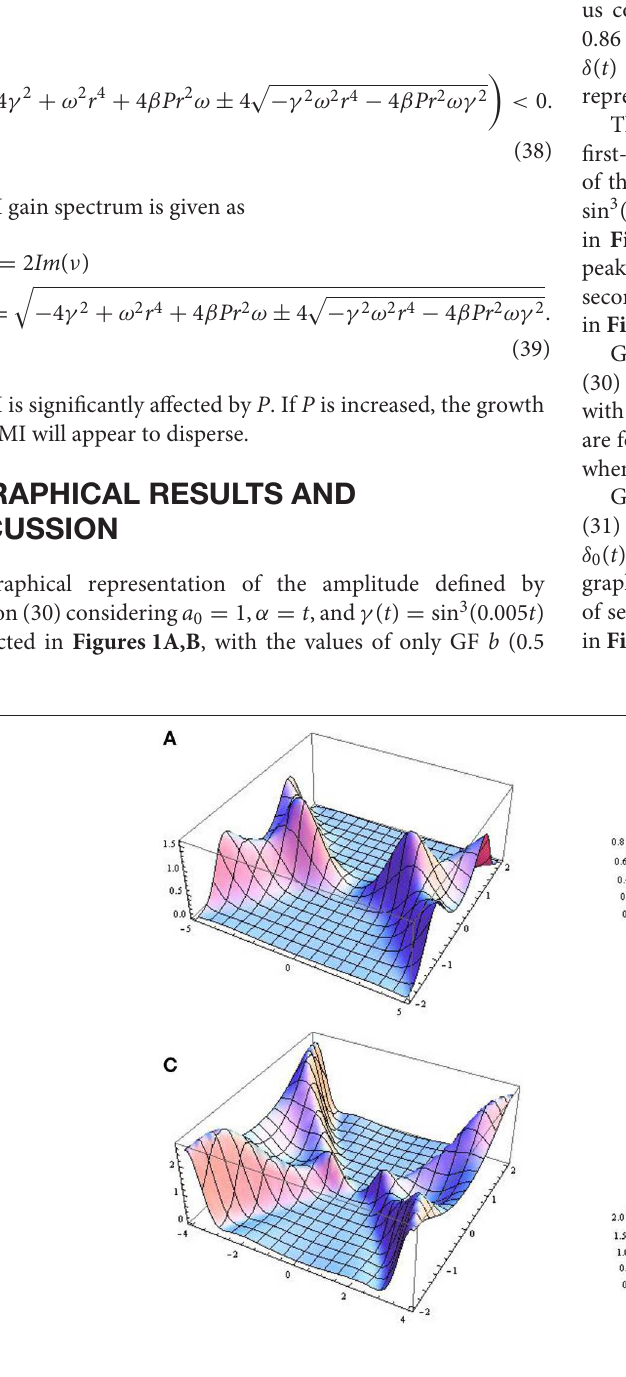
5tan 2 (0.05 t ), (C) δ ( t ) =